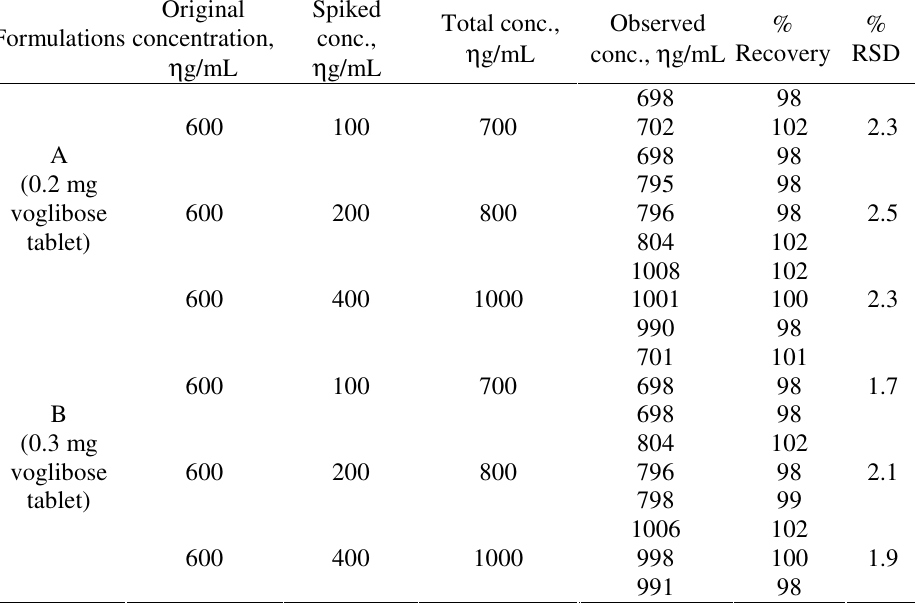
Table 5. Recovery studies for the determination of voglibose using LC-MS/MS (Spiked in triplicate at each concentration